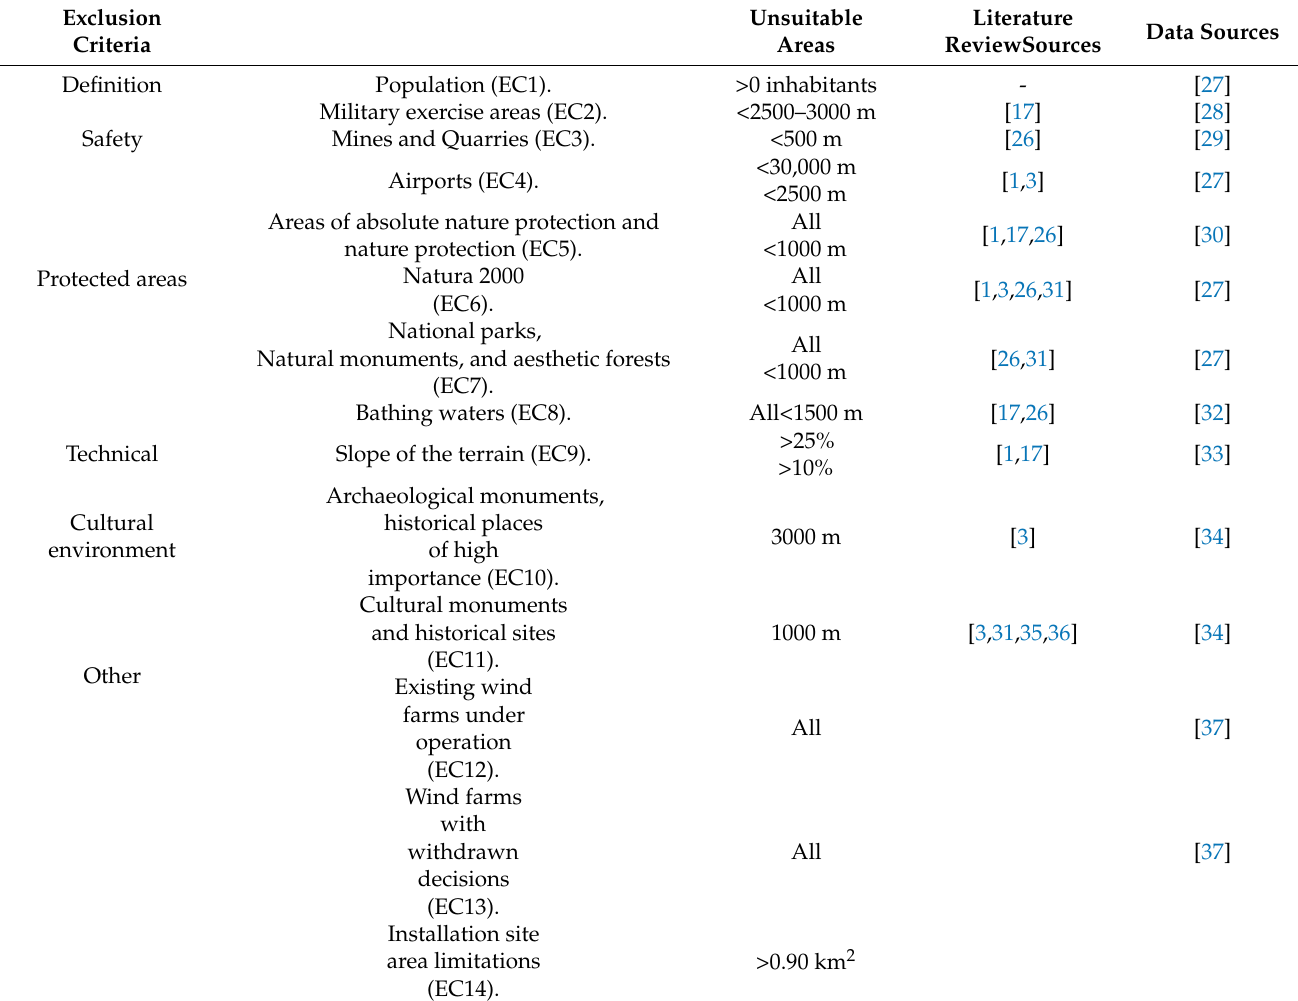
Table 1. Exclusion criteria for the deployment of wind farm projects in UIs in the region of the South Aegean,